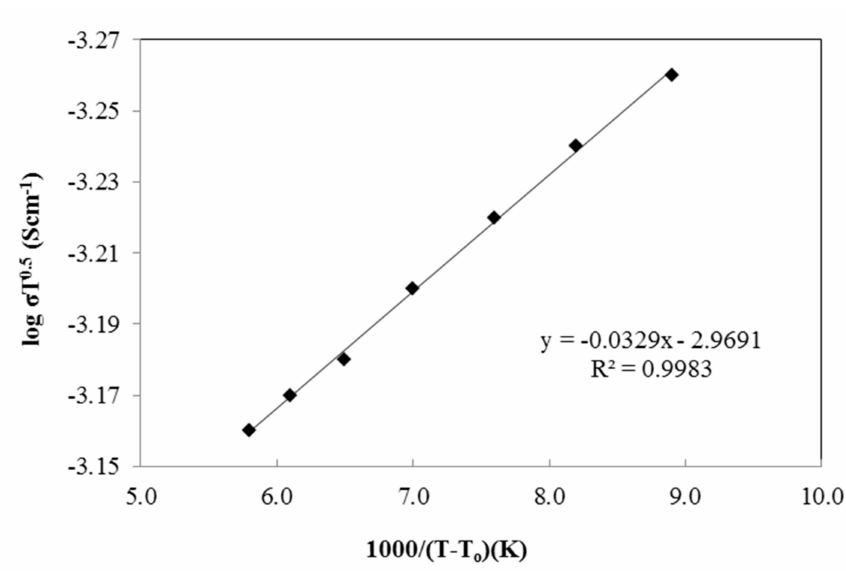
Figure 12. The VTF plot of PU-25LiClO 4